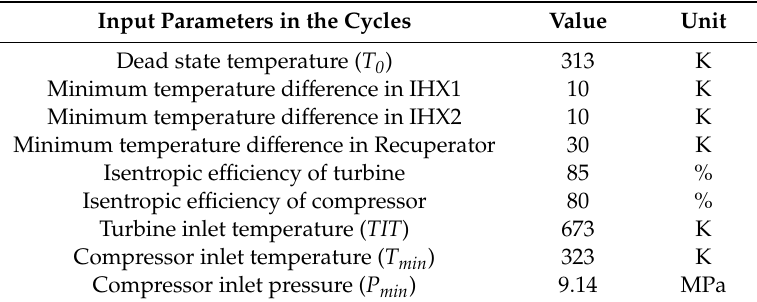
Table 5. Base conditions for the parametric study [25,45].